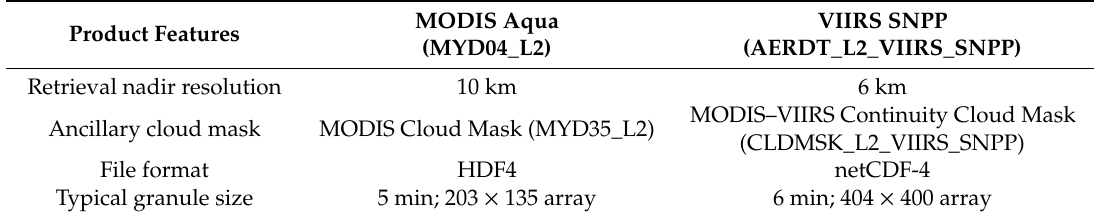
Table 1. Key di ff erences between the Dark Target (DT) retrieval products for MODIS and the Visible Infrared Imaging Radiometer Suite